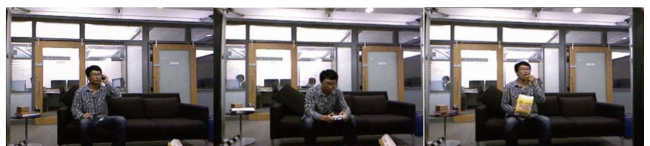
Figure 20. Samples from MSR Daily Activity 3D dataset [87].